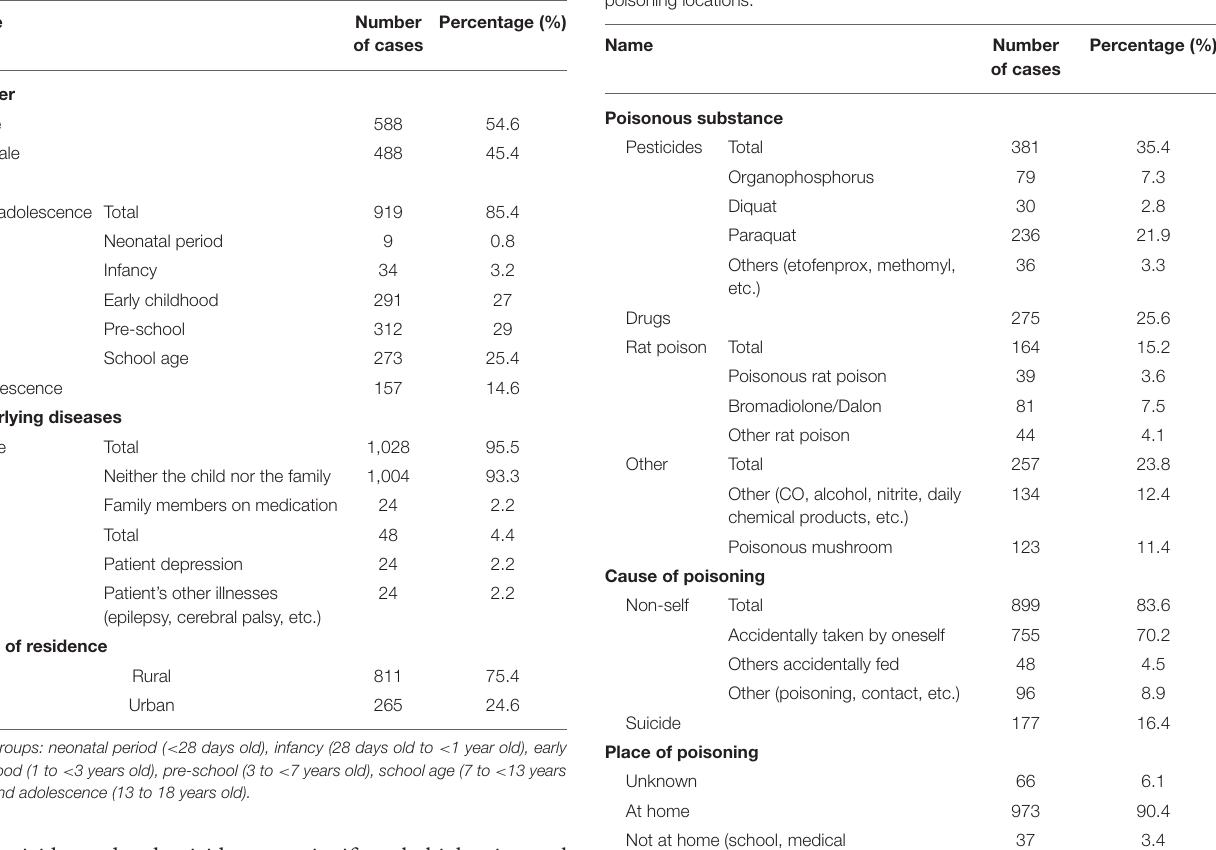
TABLE 1 | Basic characteristics of hospitalized children with acute poisoning.